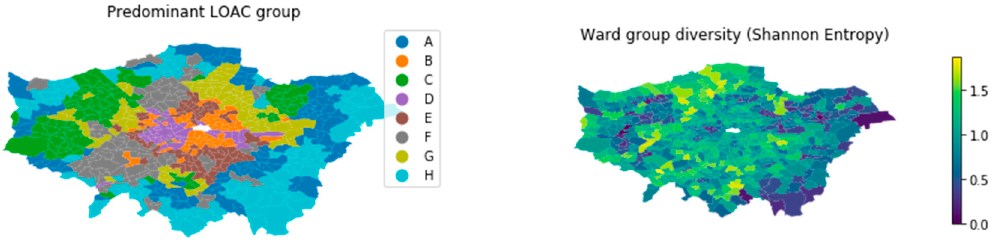
Figure 7. Distribution of predominant LOAC super-groups ( left ) and Shannon Entropy (diversity of groups, right).